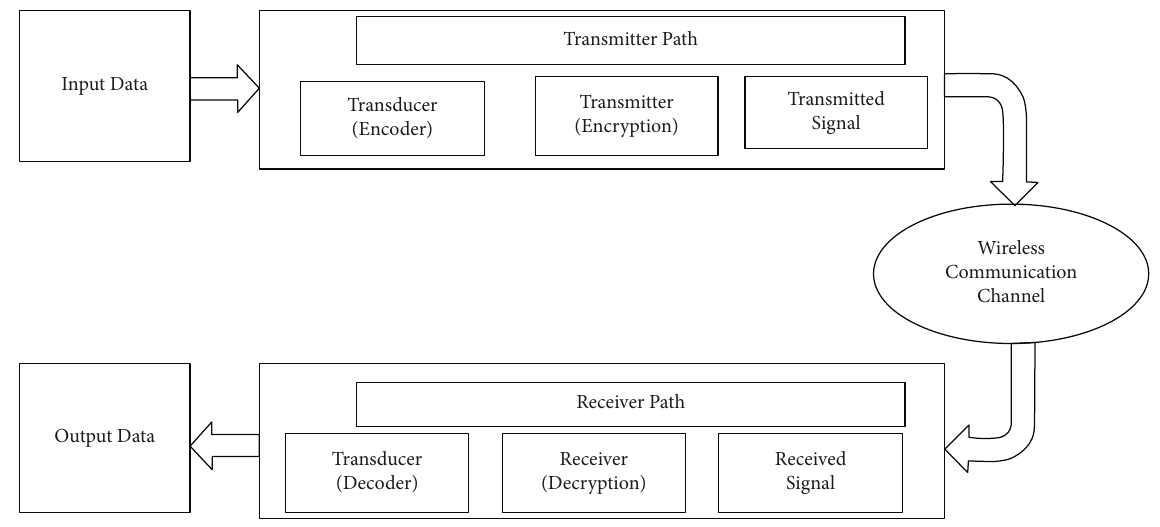
Figure 1: Wireless communication network